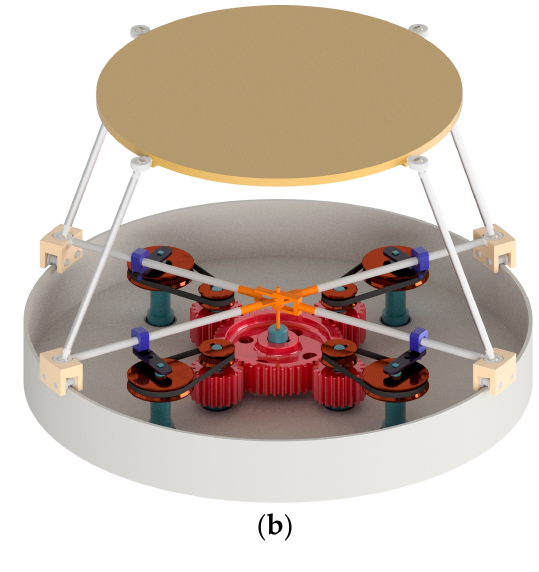
( d ) Figure 2. CAD models of the synthesized mechanisms with a reconfigurable design: ( a ) tripod; ( b ) quadropod; ( с ) penta- pod; ( d ) hexapod.